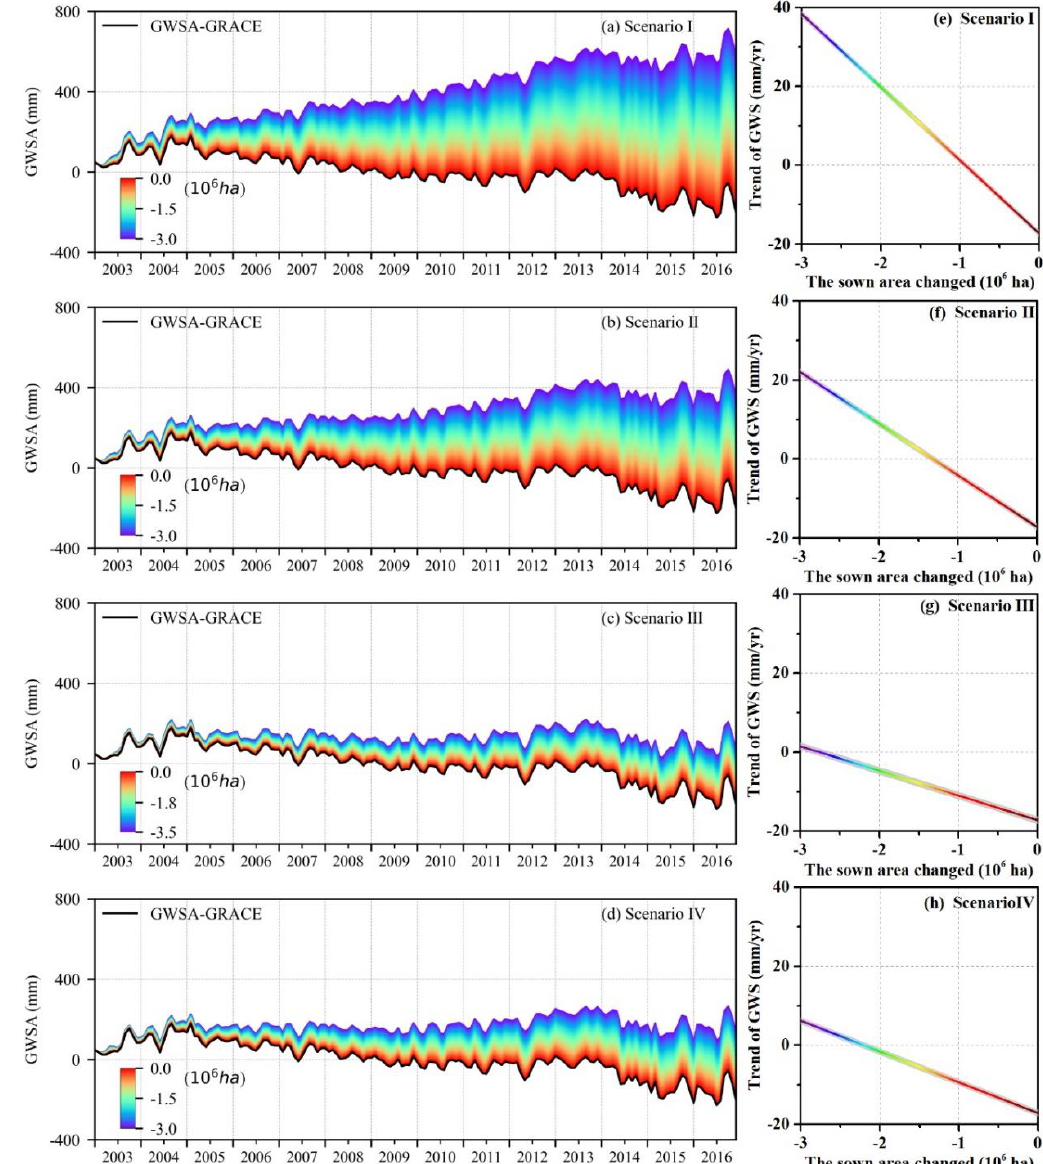
Figure 10. The 2003–2016 monthly GWSA ( a – d ) and GWS trend ( e – h ) in the NCP from GRACE and the scenario simulation. Scenarios I–III refer to reducing the sown area of winter wheat and summer maize (I), winter wheat (II) and summer maize (III), and Scenario (IV) refers to reducing the sown area of winter wheat and increasing the sown area of summer maize by the same amount. The color shading bar represents the reduction range of winter wheat and maize sown area (I), winter wheat sown area (II), maize sown area (III), and winter wheat sown area (IV). The grey shaded line the error trend in GWSA ( e – h ).